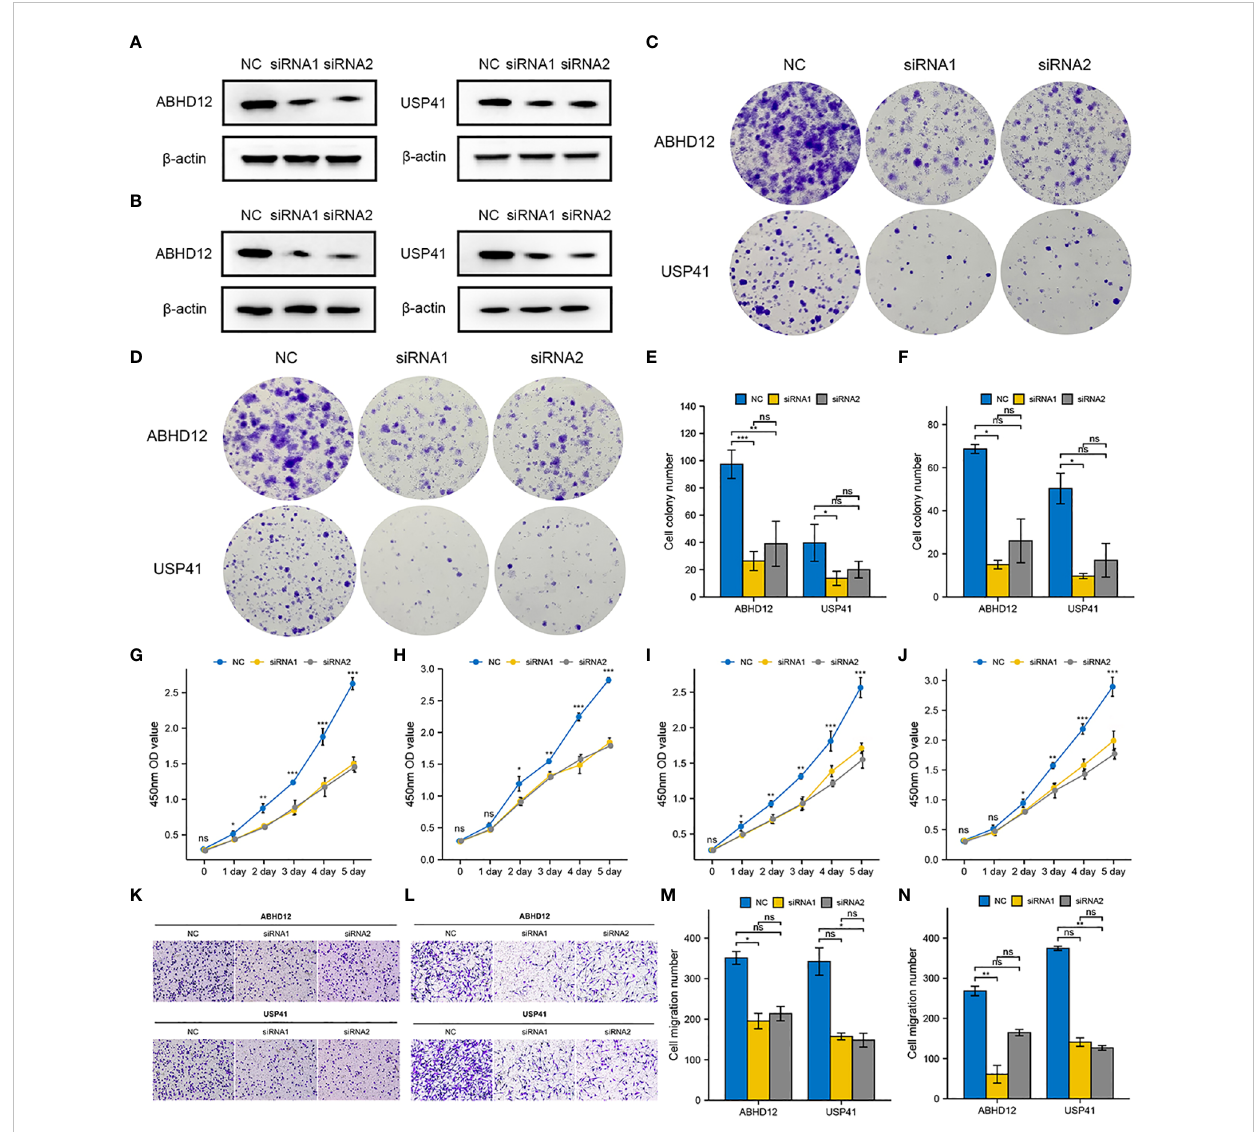
FIGURE 12 Effects of ABHD12 and USP41 on cell proliferation and migration. (A) Evaluation of silencing of ABHD12 and USP41 via western blotting in MCF-7 cells. (B) Evaluation of silencing of ABHD12 and USP41 via western blotting in MDA-MB-435S cells. (C, E) Colony formation assay in MCF-7 cells. (D, F) Colony formation assay in MDA-MB-435S cells. (G, H) CCK8 assay in MCF-7 cells. (I, J) CCK8 assay in MDA-MB-435S cells. (K, M) Transwell assay in MCF-7 cells. (L, N) Transwell assay in MDA-MB-435S cells. ‘ * ’ indicates P -value < 0.05; ‘ ** ’ indicates P -value < 0.01; ‘ *** ’ indicates P -value < 0.001. "ns" represents non-signi fi